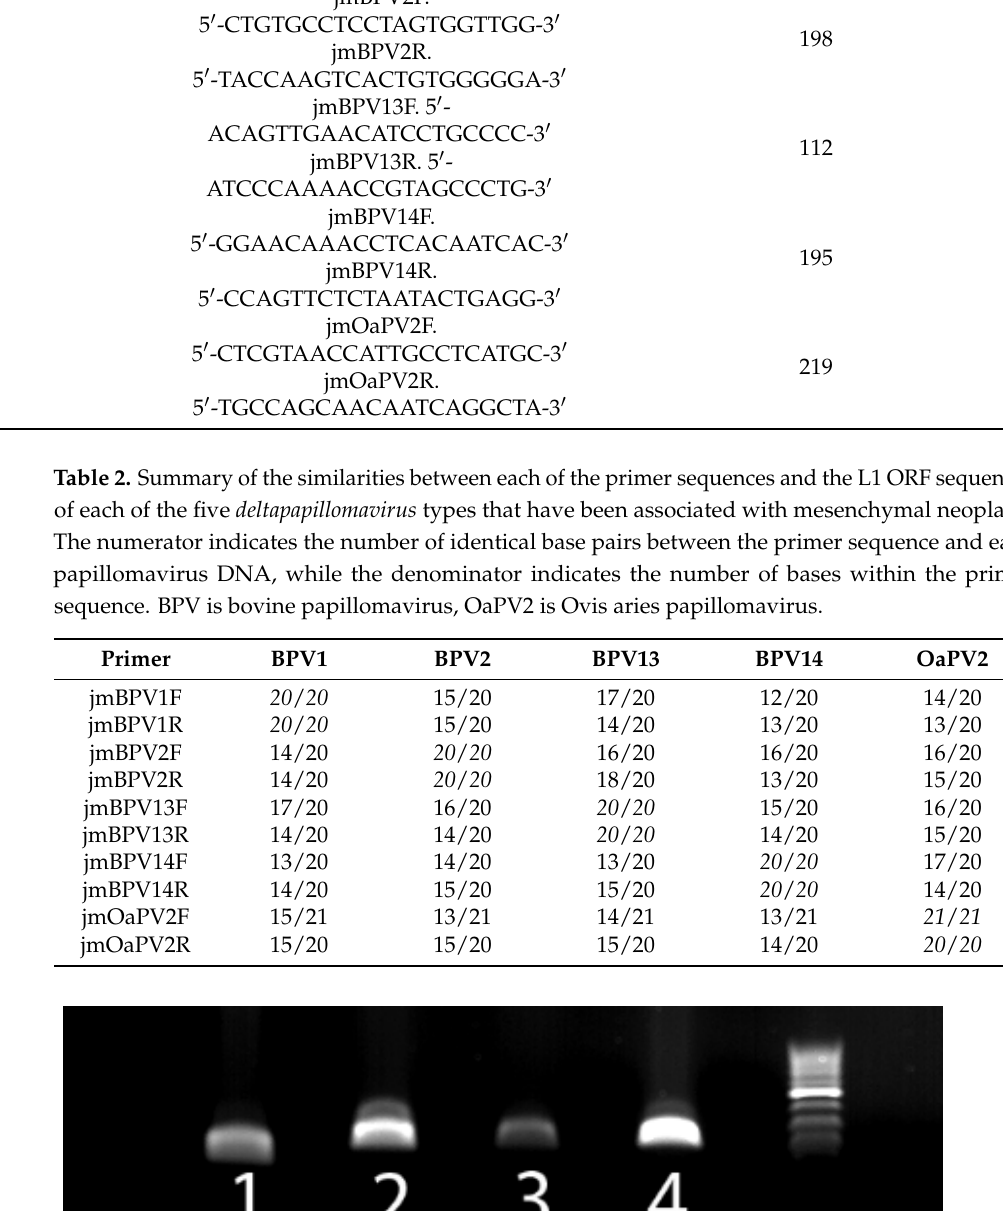
Table 2. Summary of the similarities between each of the primer sequences and the L1 ORF se- quences of each of the five deltapapillomavirus types that have been associated with mesenchymal neoplasia. The numerator indicates the number of identical base pairs between the primer sequence and each papillomavirus DNA, while the denominator indicates the number of bases within the primer sequence. BPV is bovine papillomavirus, OaPV2 is Ovis aries papillomavirus.